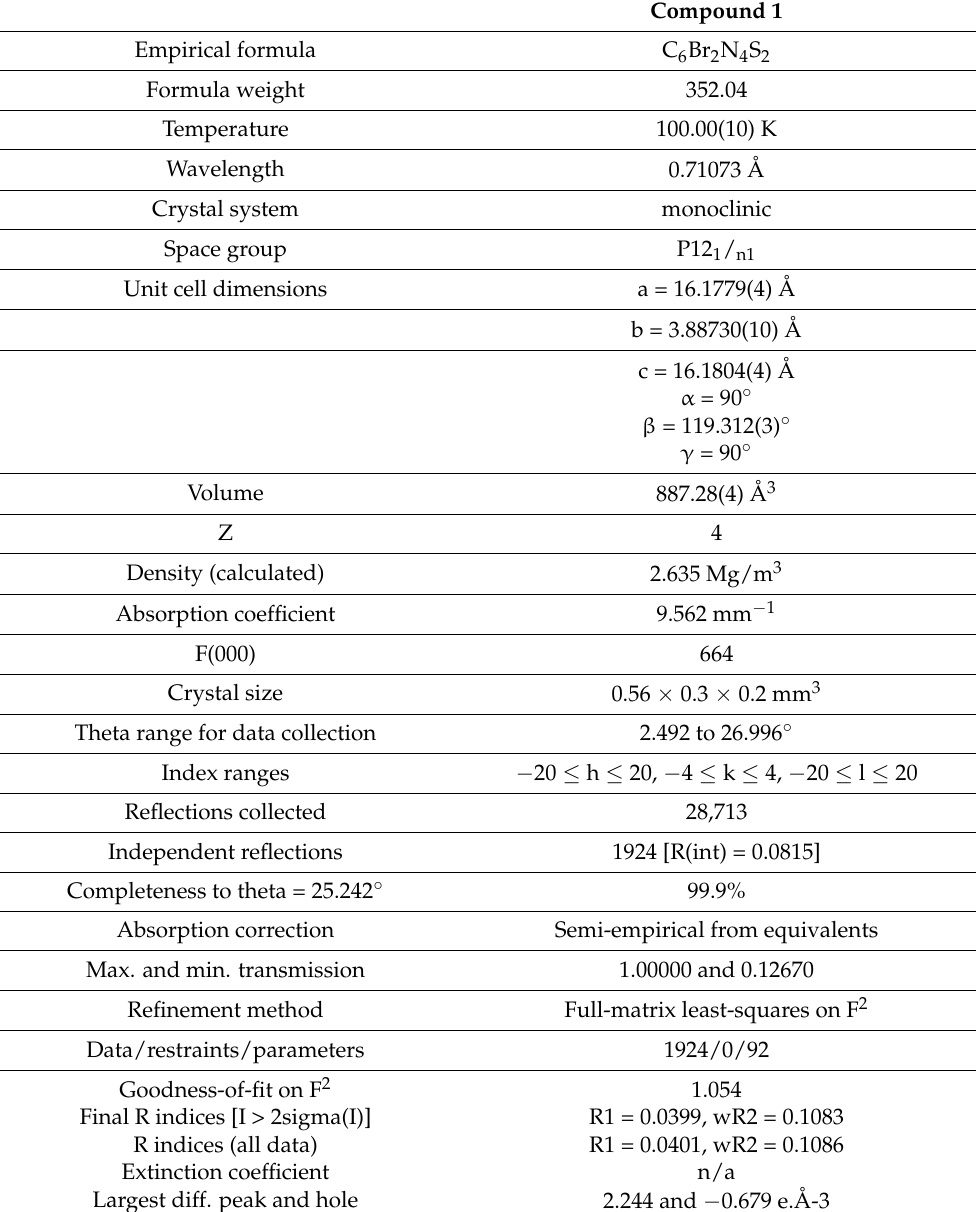
Table 7. Crystal data and structural refinement for compound 1